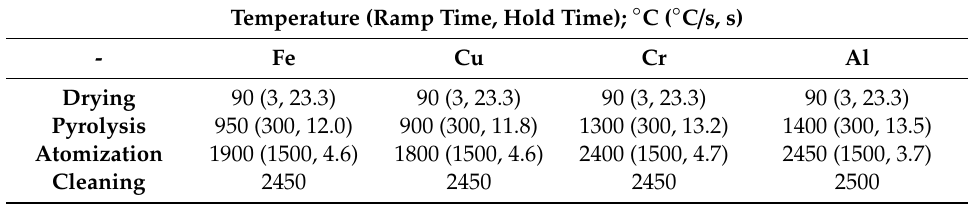
Table 1. Temperature programs for Fe, Cu, Cr, and Al determination in seeds by high-resolution continuum source electrothermal atomic absorption spectrometry (HRCS